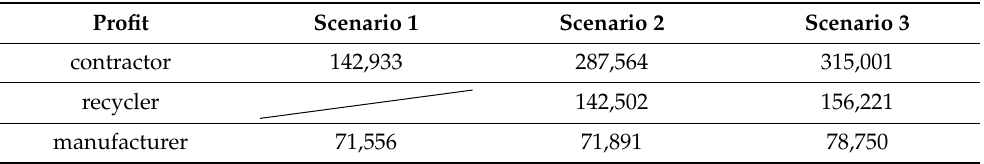
Table 4. Optimal profits under different scenarios.